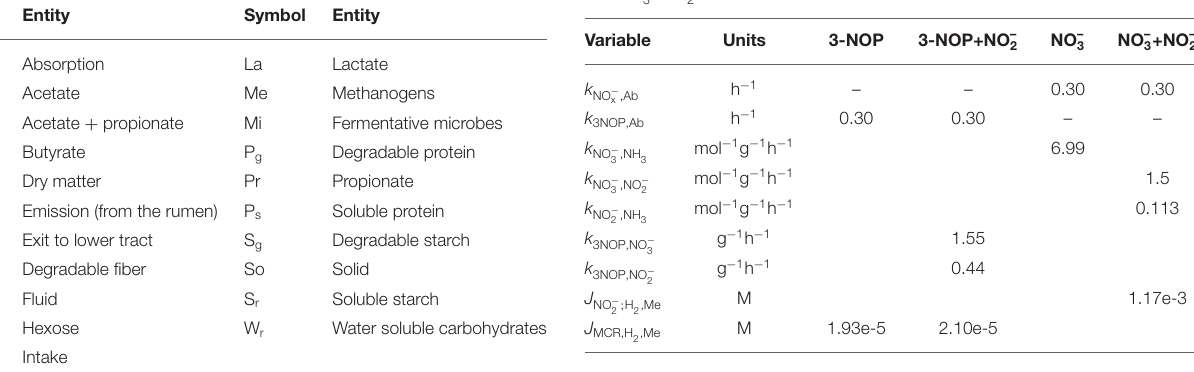
TABLE 2 | Abbreviations used in mathematical expressions in the model. TABLE 3 | Preliminary parameter values used in the 3-NOP, 3-NOP+NO – 2 , NO – 3 , and NO – 3 +NO – 2 models.